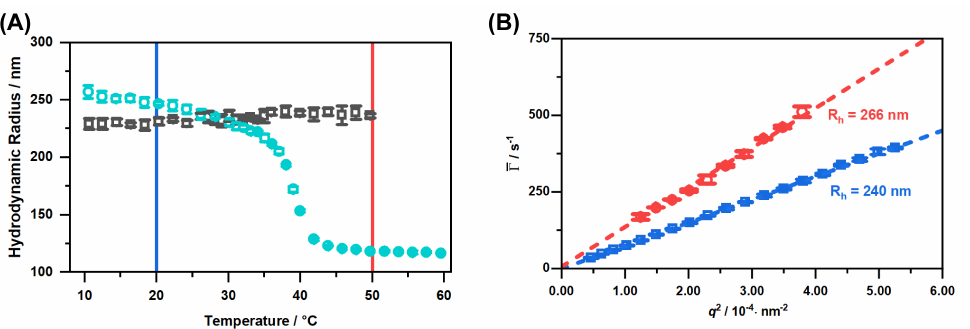
Figure 5. Hydrodynamic radius of the copolymer microgels obtained by temperature-dependent PCS measurements. The black squares represent the result of the measurements in EtOH and the blue circles the result from the measurements in water, given for comparison ( A ). Average relaxation rates ¯ Γ plotted against q 2 ( B ) measured with angle-dependent PCS in EtOH at the temperatures 20°C (blue) and 50°C (red). Dotted coloured lines are linear fits used to determine the translational diffusion